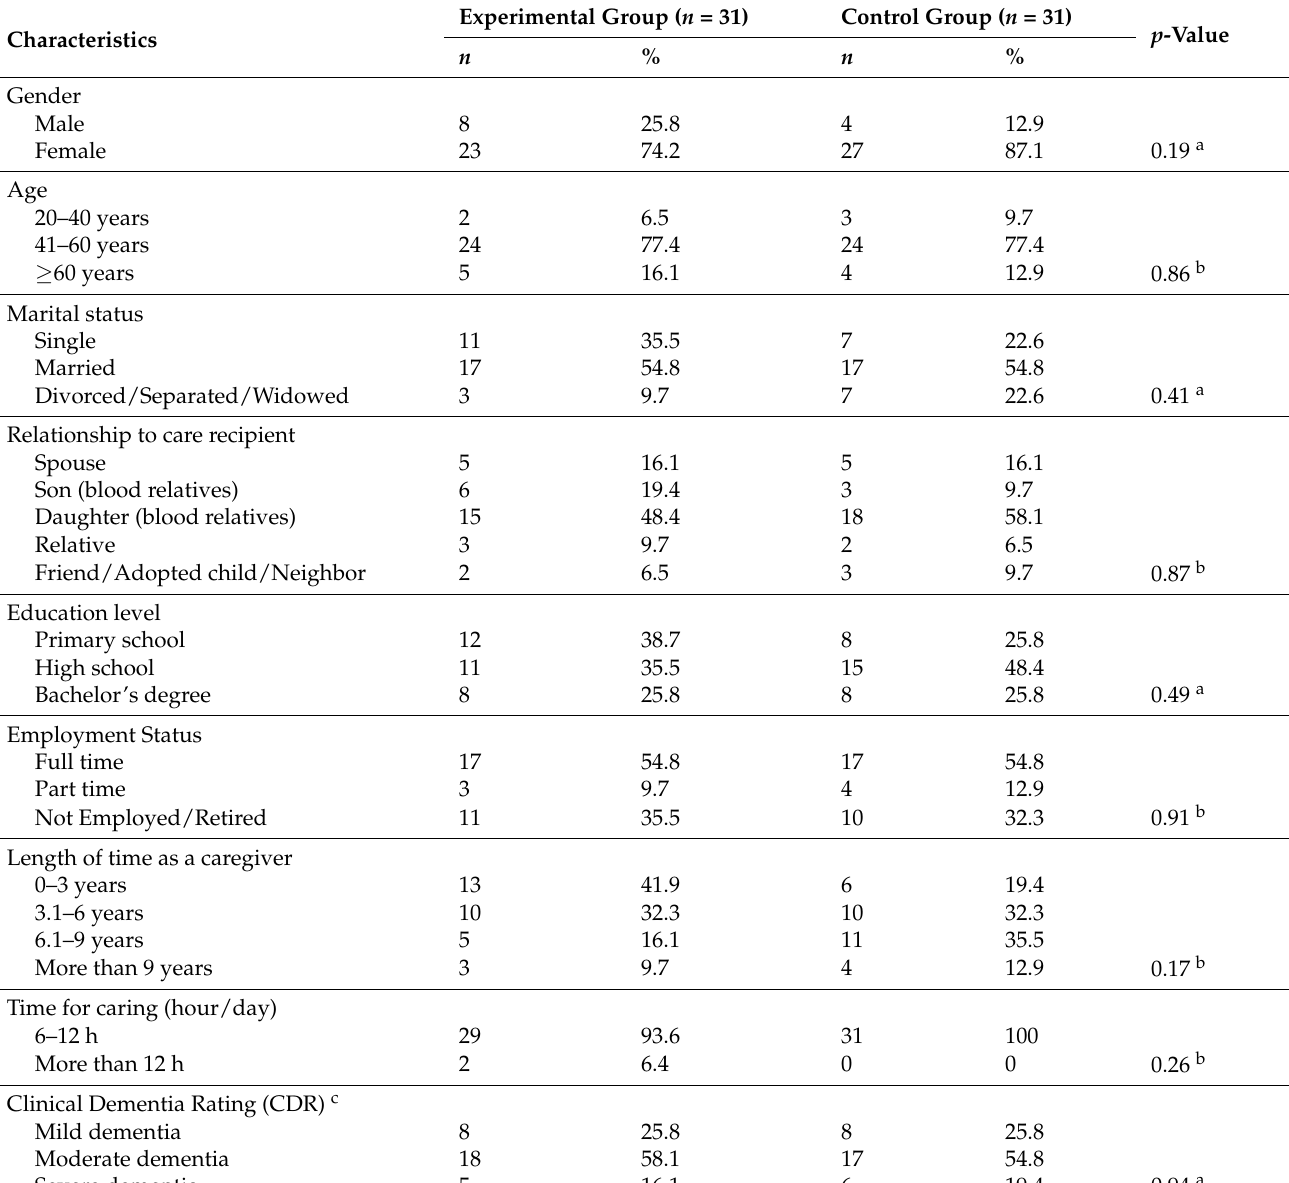
Table 2. Baseline demographic characteristics of the experimental and control groups.